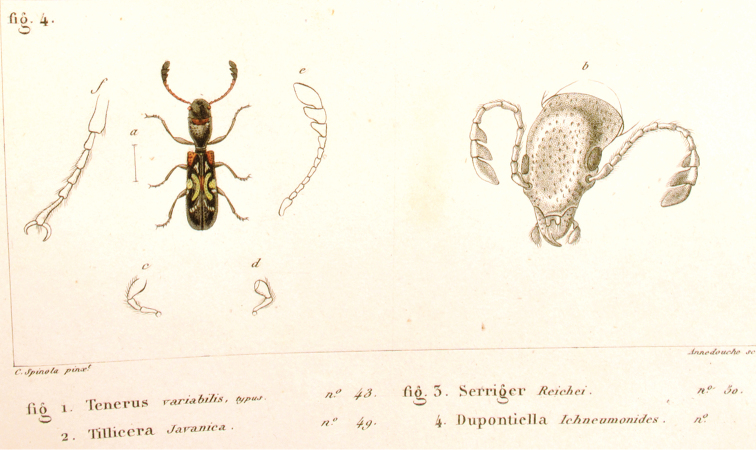
A facsimile of Spinola 1844: Tab XII, fig. 4 (15). The original illustrations of Dupontiella ichneumonoides.